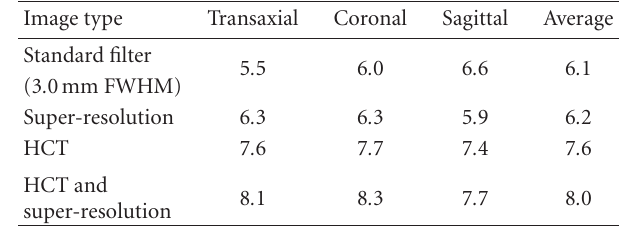
Table 3: Super-resolution point spread function FWHM values for phantom trials.